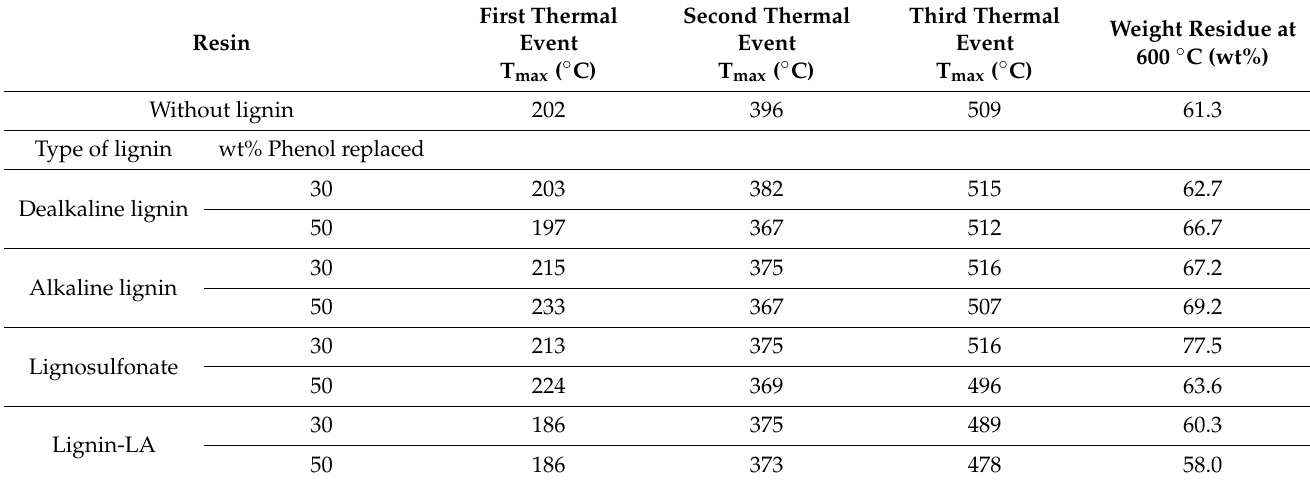
Table 2. Summary of the main thermal properties of BPF